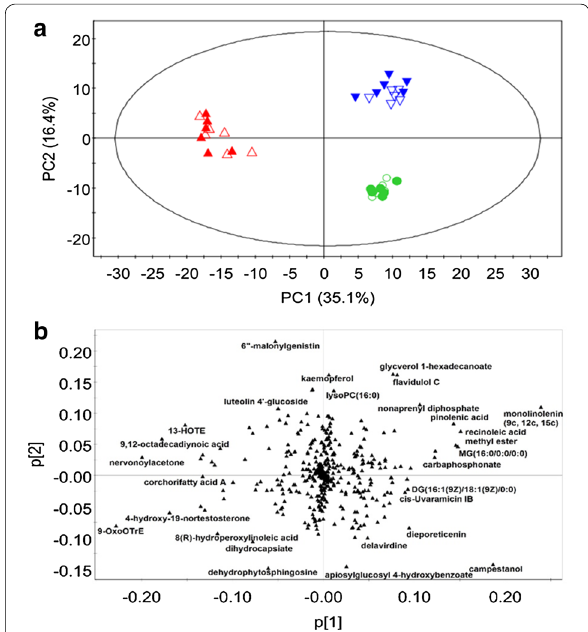
Fig. 3 PCA derived from LC–MS/MS data for drought‑tolerant transgenic soybean ‘ABF3’ (filled symbols) and ‘Kwangan’ WT (open symbols) grown under non‑drought (blue open triangle, blue filled triangle), mild‑drought (red inverted open triangle, Red inverted filled triangle), and moderate‑drought (green open circle, green filled circle) conditions. a Score plot (ellipse represents Hotelling T 2 with 95% confidence) and b loading plot